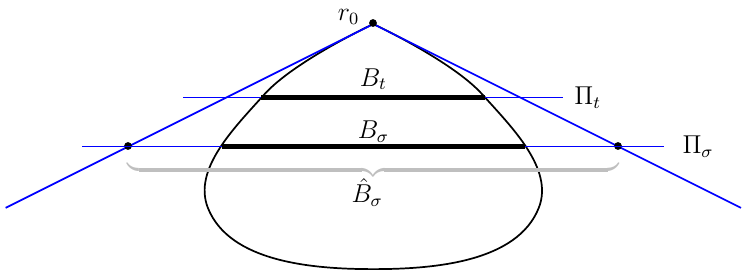
Figure 4. The tangent cone at r 0 , the cutting planes Π t and Π σ , and the sets B t , B σ , and ˆ B σ in the case Figure 4: The tangent cone at r when the point r 0 is ˆ B in the case when the point r σ